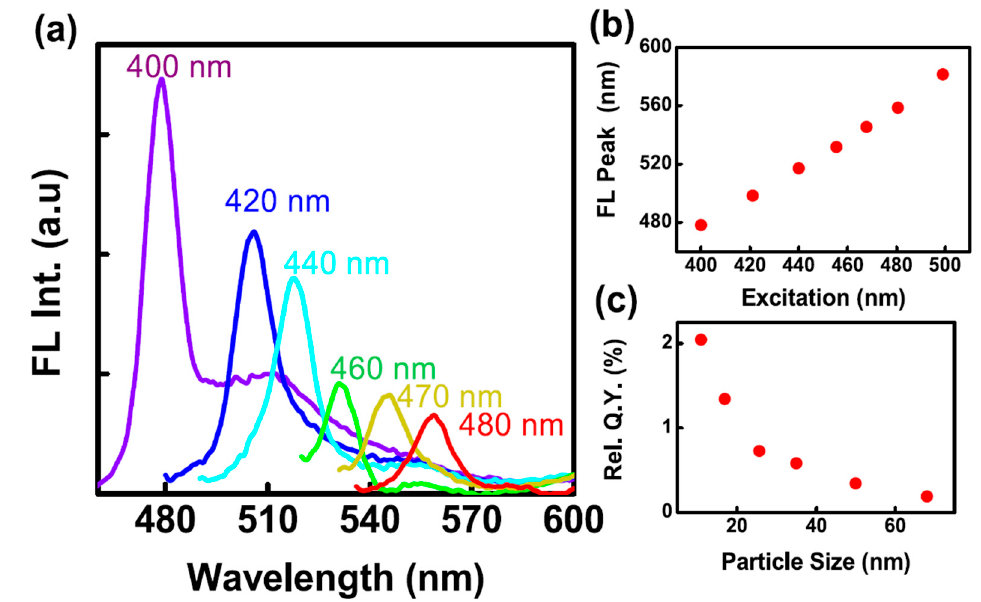
Figure 8. ( a ) The excitation-dependent fluorescent spectrum of ~17 nm MoS 2 nanoparticles. ( b ) Variation in emission peak position with excitation wavelength. ( c ) Variation of the relative quantum yield with particle size. Reproduced with permission from [42]. Copyright IOP Publishing Ltd, 2020.